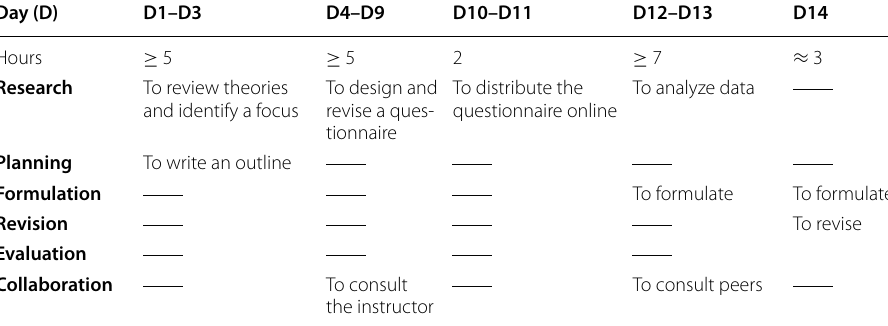
Table 2 Lucia’s processing strategies for the IC